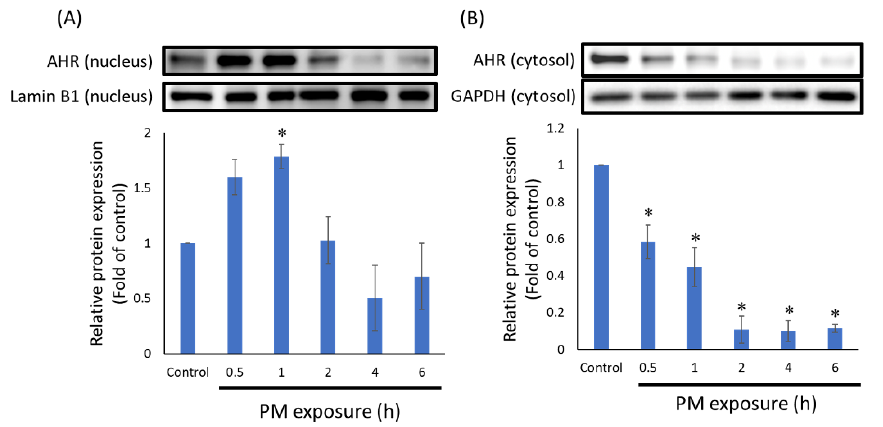
Figure 2. The time point of AHR protein translocation in keratinocytes exposed to PM. ( A ) AHR in the nucleus. ( B ) AHR in the cytosol. n = 3 for each group; * p < 0.05 compared with control.